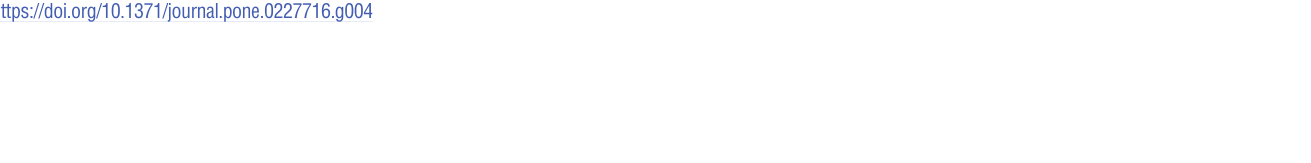
PLOS ONE | https://doi.org/10.1371/journal.pone.0227716 January 16,